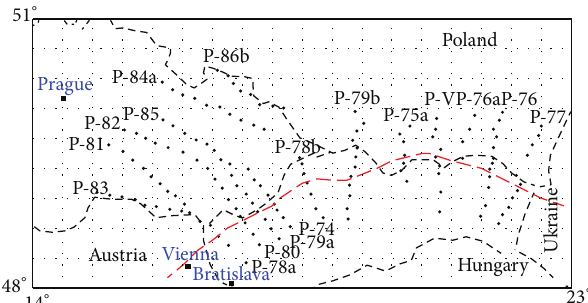
Figure 3: The study area shown in WGS84 geographical coordinates system along with GDS stations (dots), country border outline (thin dashed line), the West Carpathian anomaly (red dashed line), and discretization grids (thin dotted line) of 9 by 18 blocks with 35 by 35 km width for the thin-sheet